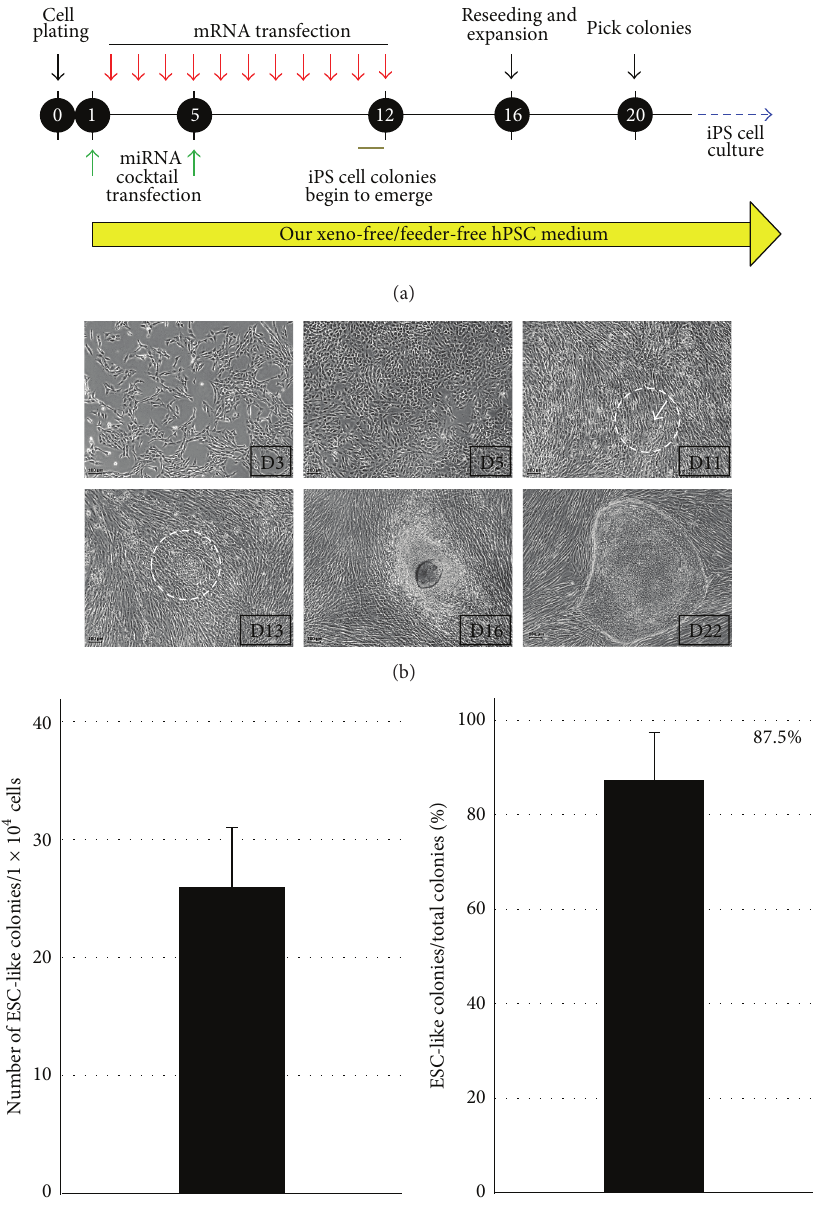
Figure 1: RNA-mediated generation of iPS cells using an ECM-based xeno-free/feeder-free hPSC medium. (a) A schematic representation of the experimental design. Human adult dermal fibroblasts were seeded on 6-well plates ( 5 × 10 4 cells per well) and were subjected to multiple transfections as shown in the schedule. (b) The ESC-like colonies began to appear on day 11 after cell seeding (see the tip of the arrow at the center of the white circle, top right panel ). The number within the square at the right bottom corner of each panel indicates the number of days passed after cell seeding. Scale bar: 100 𝜇 m. (c) The graph shows the number of ESC-like colonies generated per 10,000 fibroblasts initially seeded. (d) The percentage of ESC-like colonies among the total colonies is presented in graph